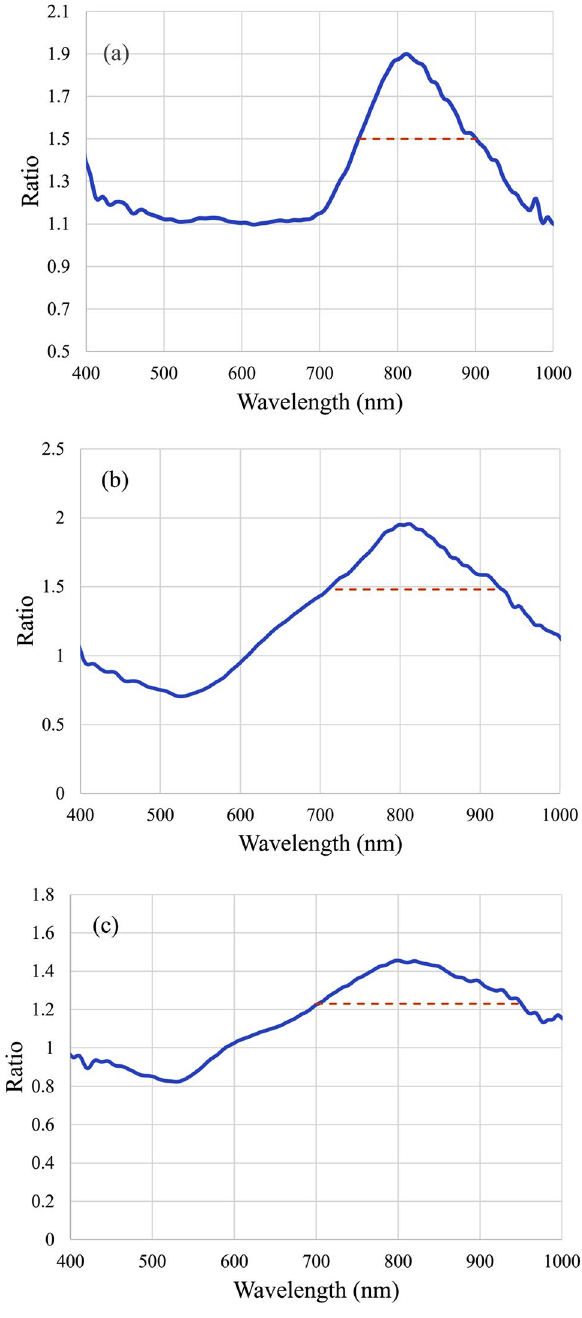
Figure 6. Ratio of absorption spectra before and after irradiating by laser with various fluences. ( a ) For 220 J/ m 2 , ( b ) for 1.1 × 10 4 J/m 2 , and ( c ) for 2.46 × 10 6 J/m 2 . Widths of spectral holes are labeled with dashed